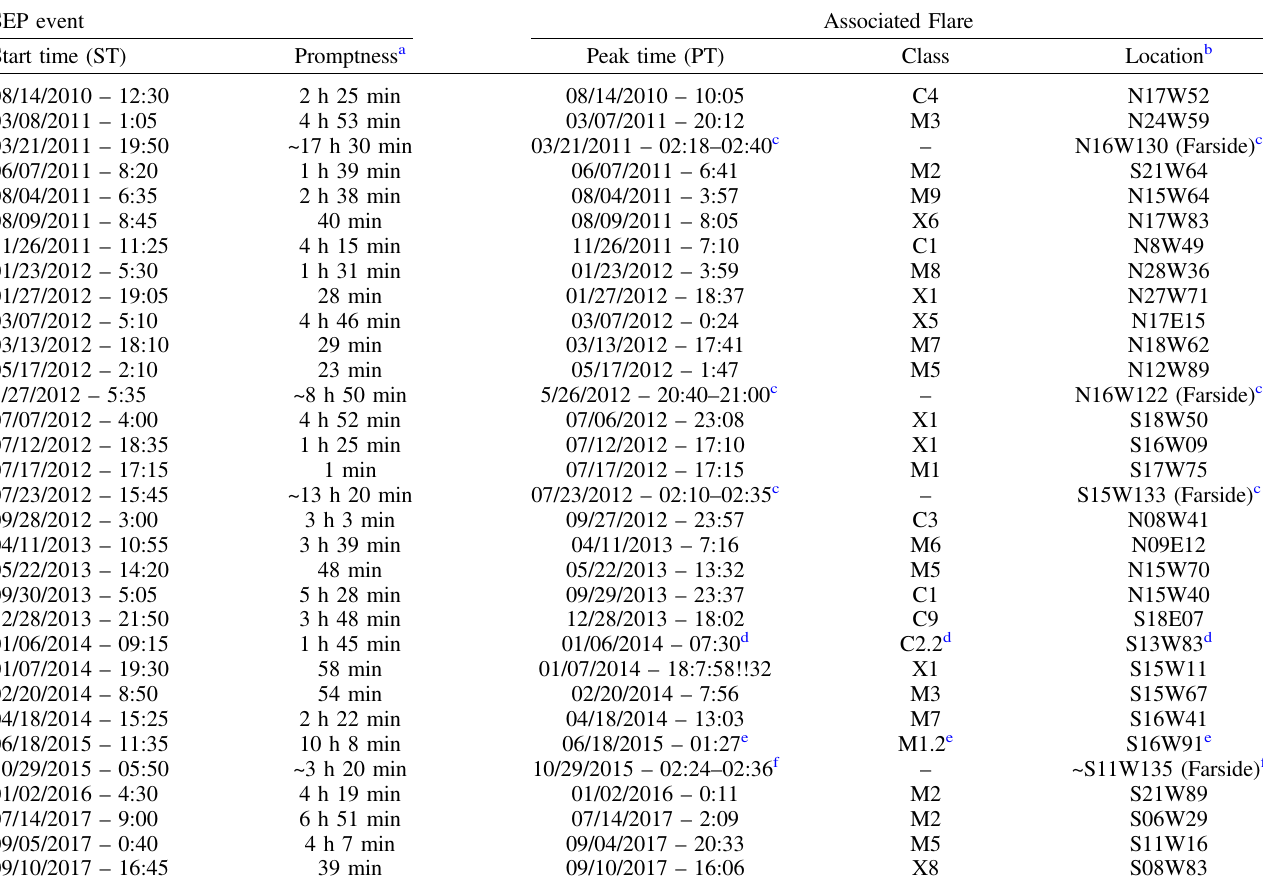
Table 1. List of prompt SEP events with energies >10 MeV which occurred from May 2010 to December